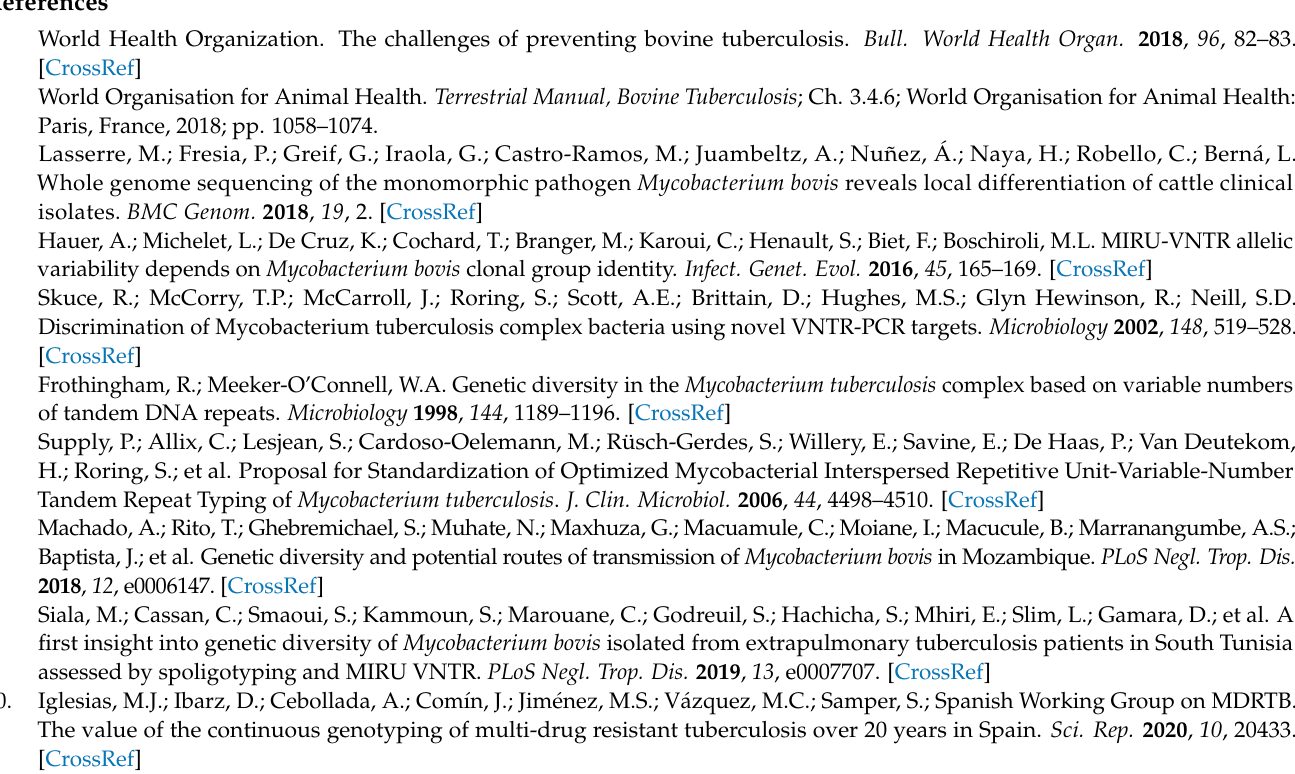
countries used for global VNTR dendrogram. Figure S1: Global VNTR-based UPGMA tree of M. bovis/M. caprae isolates. Figure S2: Parts of the global VNTR-based UPGMA tree of M. bovis/M. caprae isolates: clusters of identical isolates from different countries, and some pairs of related isolates discussed in the main text. Figure S3: 13-VNTR UPGMA tree of 34 M. bovis isolates from Bulgaria with available WGS